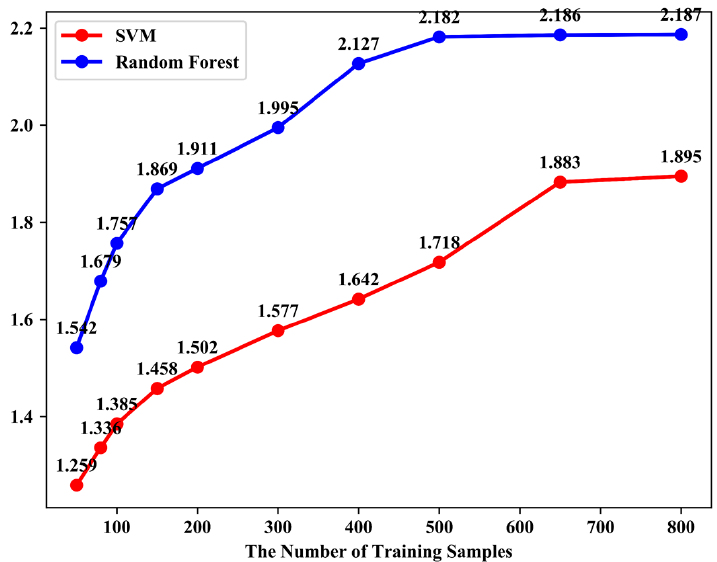
Figure 4. Curve of average factor between the random forest and the SVM in CelebA datasets (the same number of training samples and test samples). The red line represents SVM, and the blue line represents random forest.